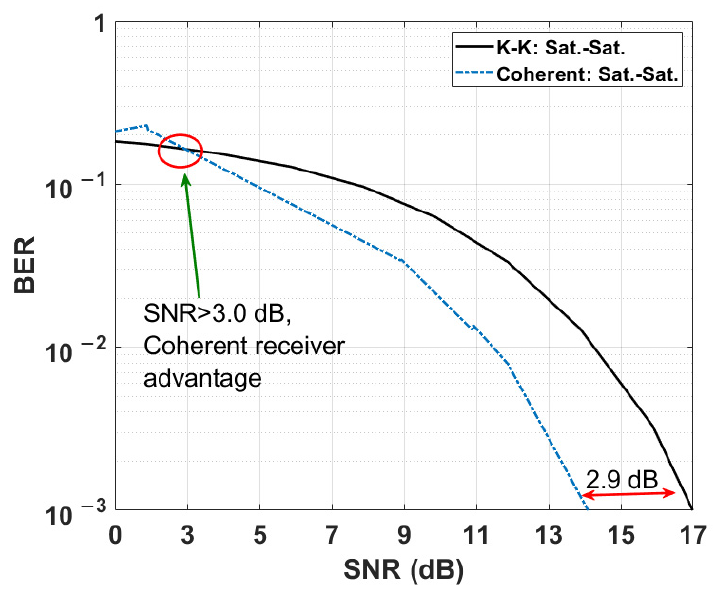
Figure 8. Comparison between coherent and KK transceivers performance versus electrical SNR (For KK transceiver: K = 10).